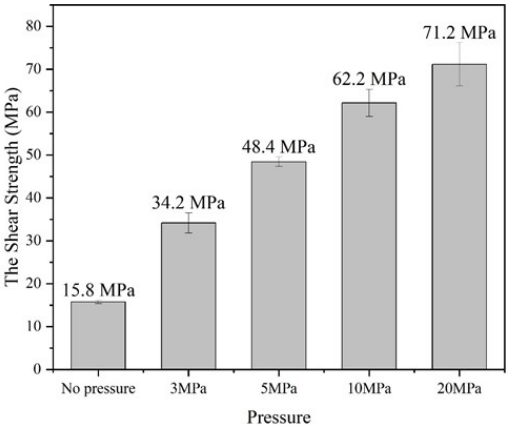
Figure 6. Shear strength of the joints obtained under different pressures.